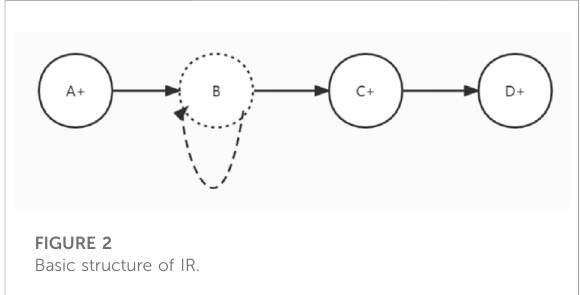
FIGURE 2 Basic structure of IR.